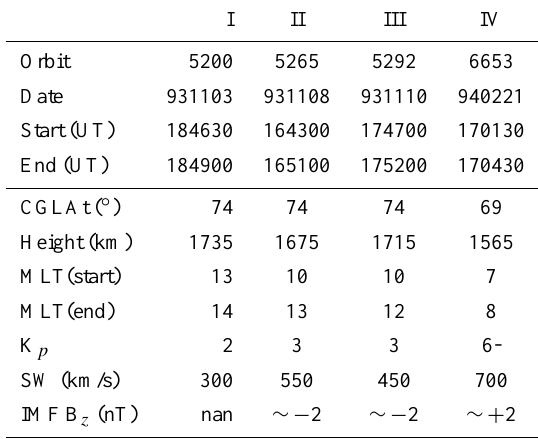
Table 1. Time, location and solar wind